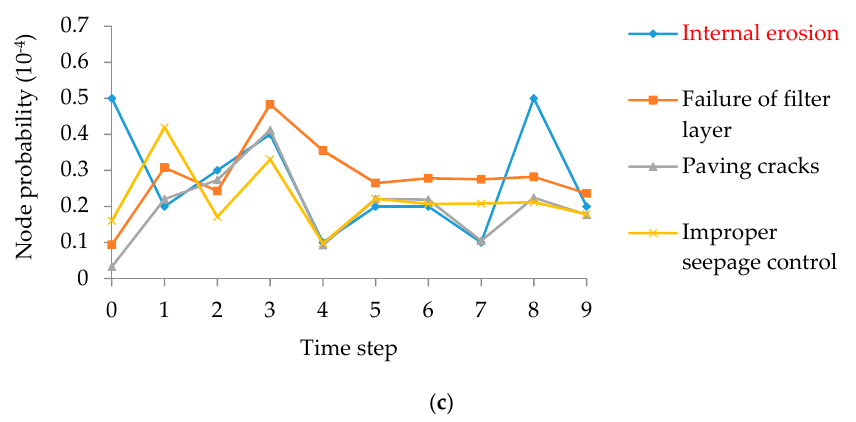
Figure 8. Time series variation curves of probability of risk factors.